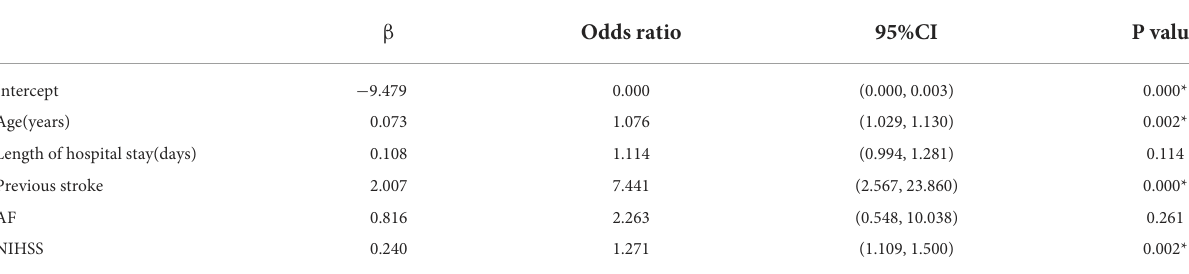
TABLE 2 Multivariate logistic regression analysis variables